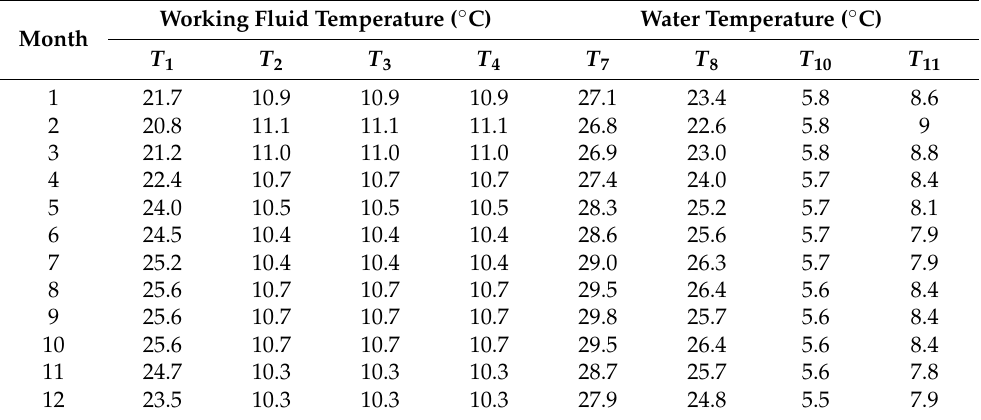
Table A2. Inlet and outlet temperature using GWR-TMCAS temperature data, considering 1 kWe of power output.